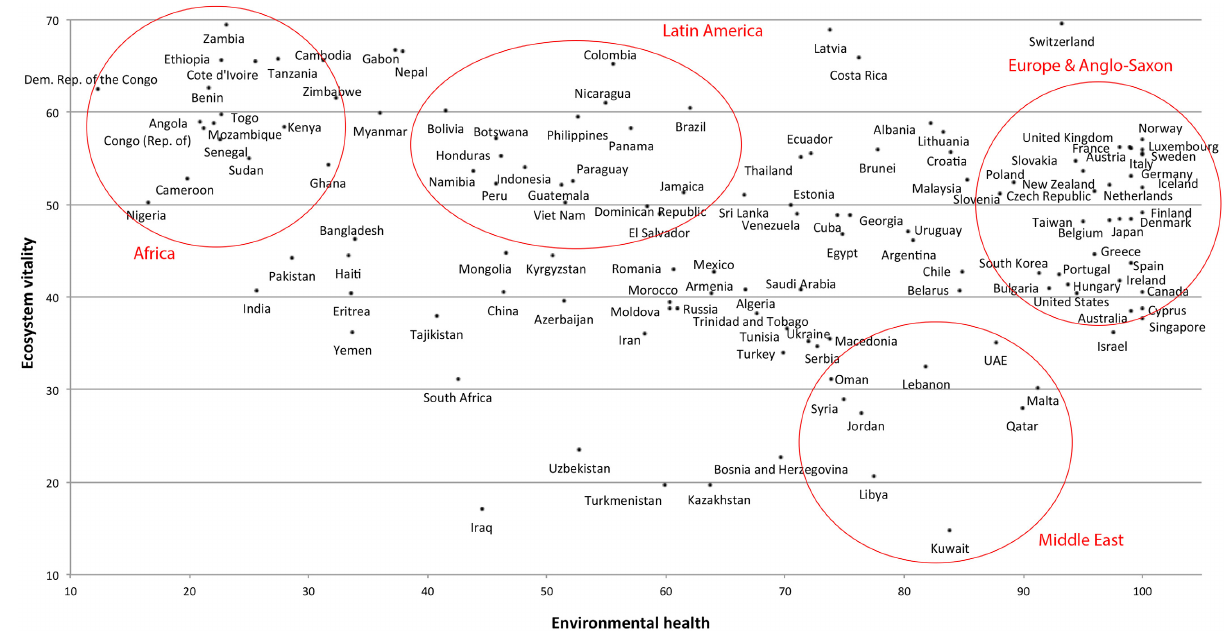
p = 0 . 82). Thus, the relationship